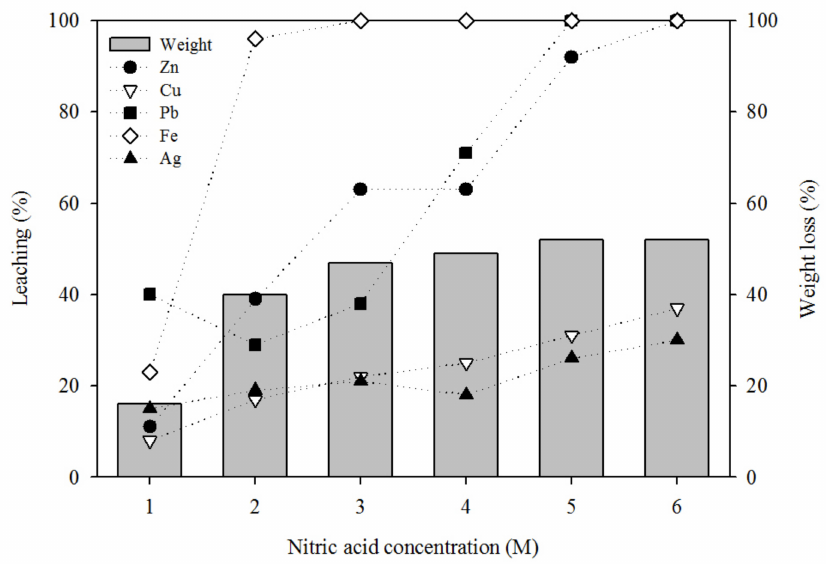
Figure 6. E ff ect of the HNO 3 concentration on the leaching e ffi ciencies of Cu, Pb, Zn, Ag, and Fe and weight loss from the gold concentrate. Leaching conditions: HNO 3 Concentration; 1.0 to 6.0 M, reaction time; 15